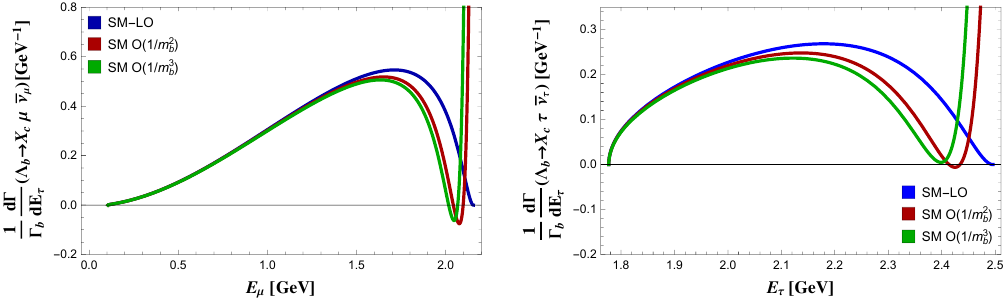
Figure 2 . Charged lepton energy spectrum in SM for (cid:3) b ! X c ‘ (cid:22) (cid:23) ‘ , with ‘ = (cid:22) (left) and ‘ = (cid:28) (right). The result at leading order in the HQE (blue line), at O (1 =m 2 (green line) are displayed.